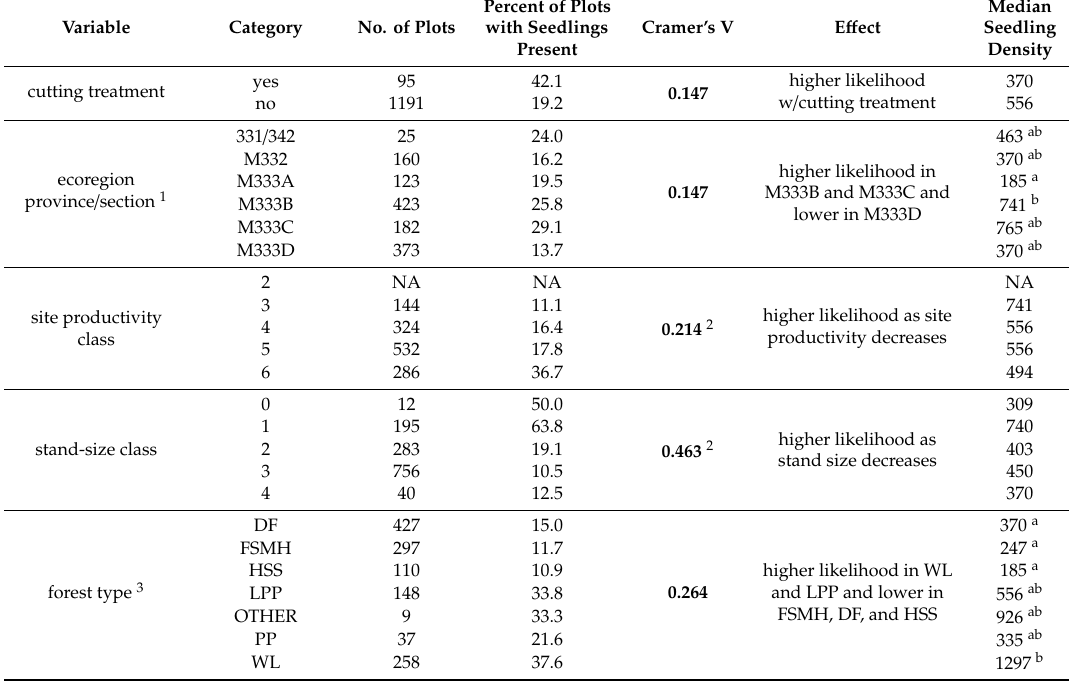
Table 3. Results of analyses of western larch seedling presence and density for nine categorical predictor variables. Predictors with significant associations according to Chi-square contingency tests have Cramer’s V scores in bold ( α = 0.05). Significant di ff erences in seedling density between individual categories for each variable according to Kruskal-Wallis (for multiple comparison) or Wilcoxon rank sum tests (for single comparisons) are indicated by di ff erent letters next to their median seedling density